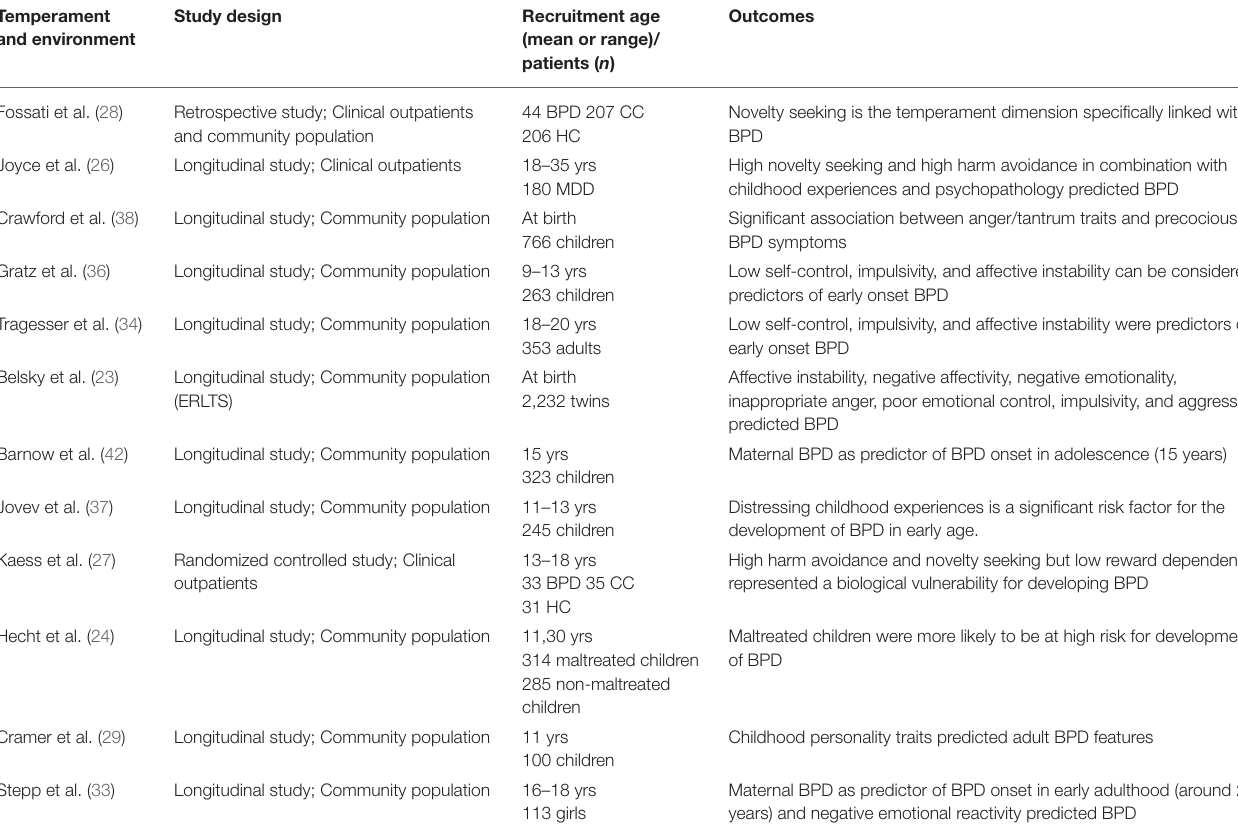
TABLE 1 | Studies on temperamental and environmental factors associated to early onset BPD. Temperament and